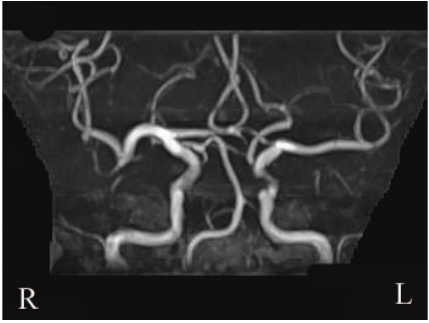
Figure 6: Postoperative MRA revealed partial stenotic changes of right